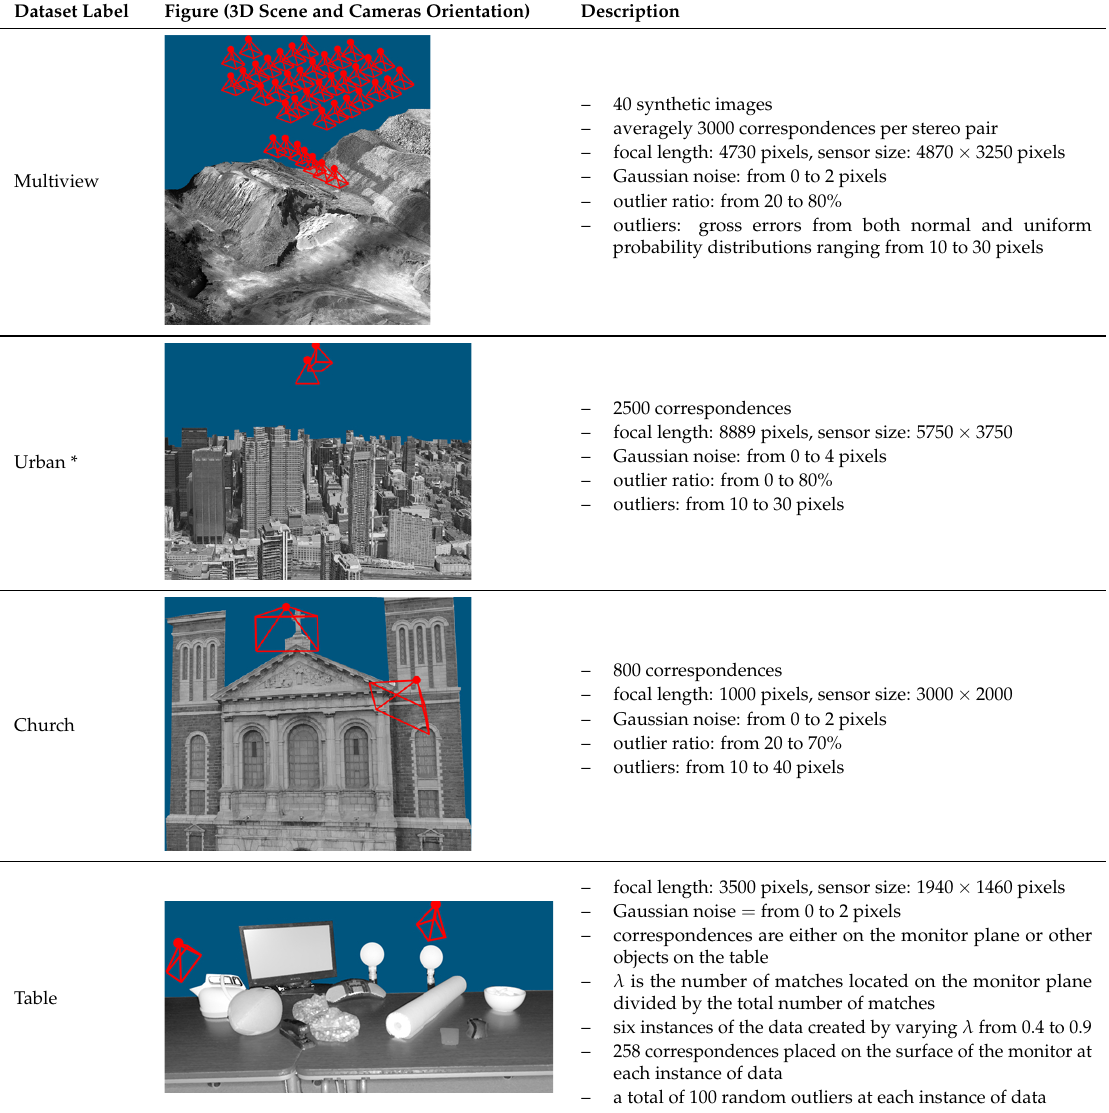
– focal length: 3500 pixels, sensor size: 1940 × 1460 pixels – Gaussian noise = from 0 to 2 pixels – correspondences are either on the monitor plane or other objects on the table – λ is the number of matches located on the monitor plane divided by the total number of matches – six instances of the data created by varying λ from 0.4 to 0.9 – 258 correspondences placed on the surface of the monitor